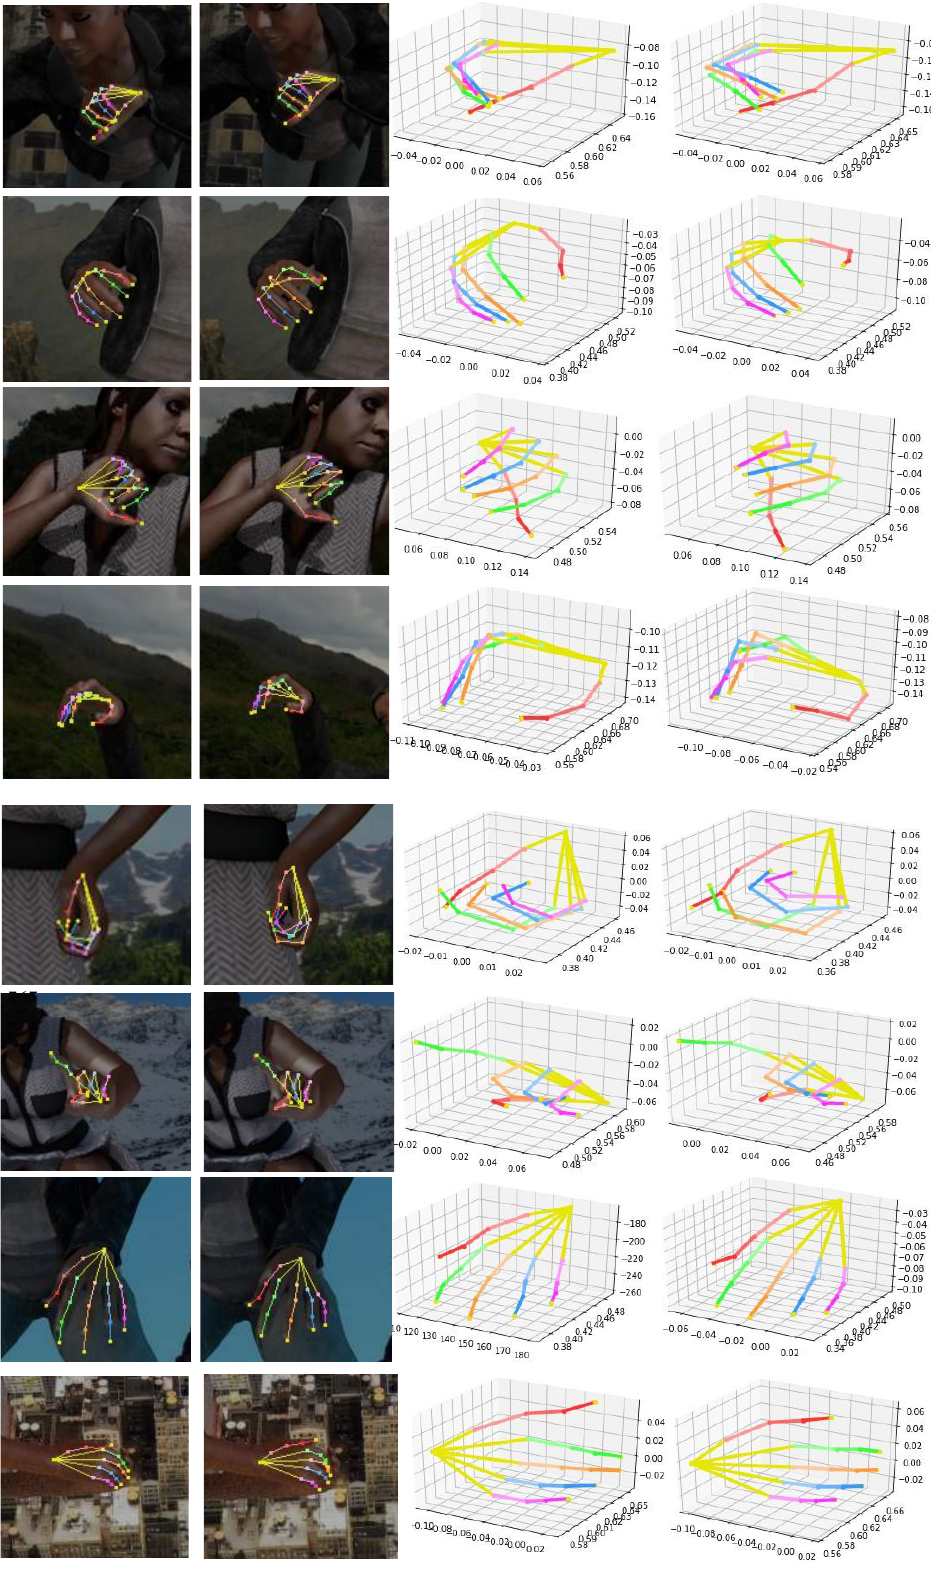
Figure 7. Comparison between the estimated 2D/3D key-points and ground-truth 2D/3D key-points on the RHD dataset. The first column shows our 2D results. The second shows the ground-truth 2D key-points. The third column is our 3D results and the fourth is the ground-truth 3D points.